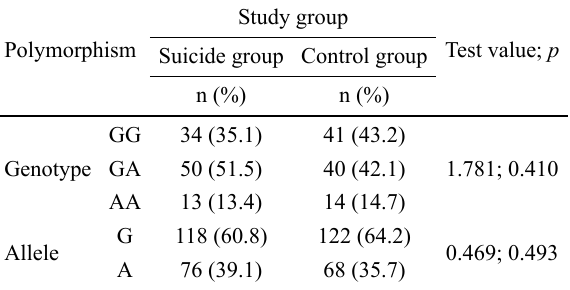
Table 6. Comparison of study groups in terms of TPH-2 gene